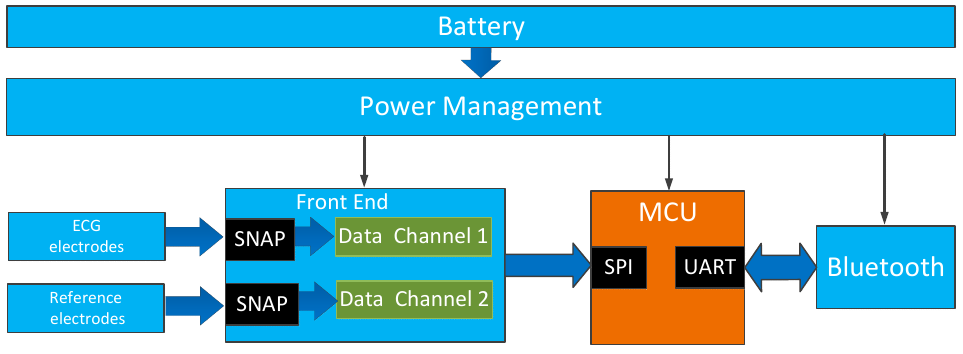
Figure 4. Block diagram of the system.